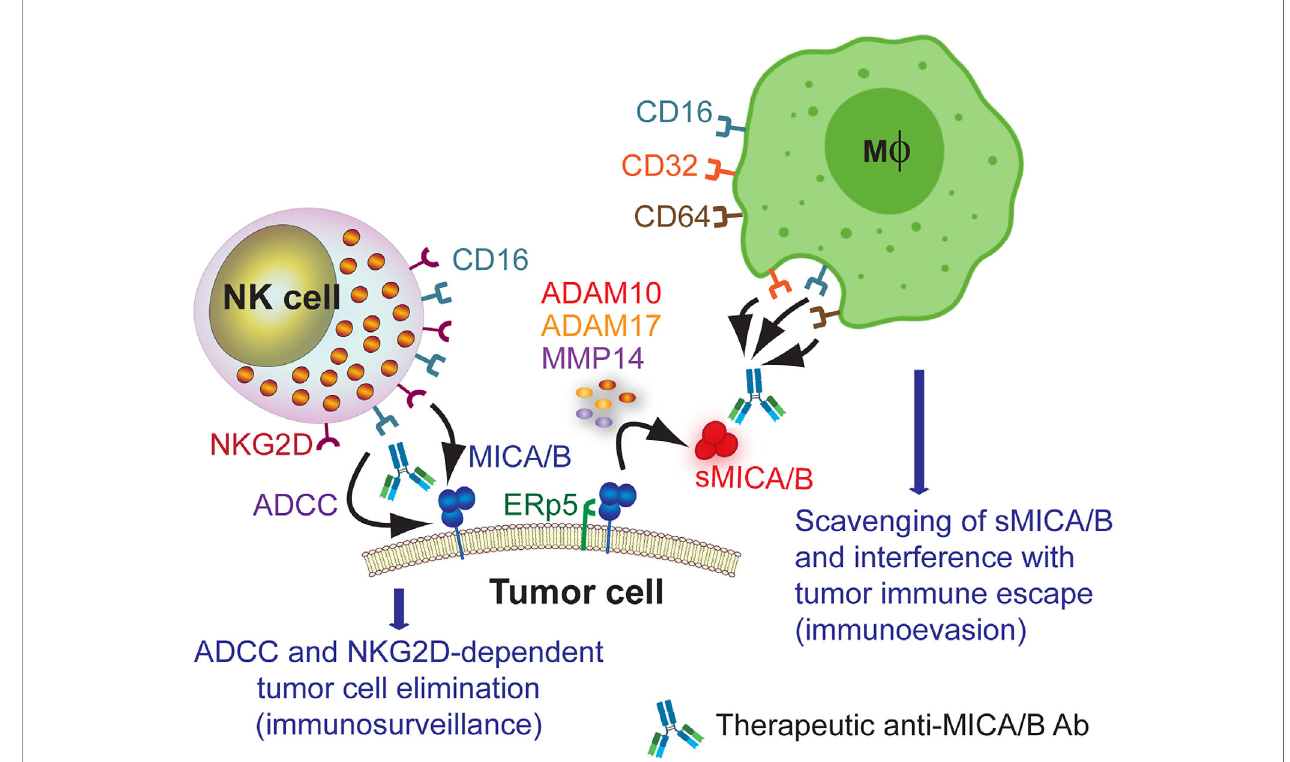
FIGURE 2 | Therapeutic opportunity for anti-MICA/B Ab. Administration of anti-MICA/B Ab may trigger CD16-dependent ADCC by NK cells when these Ab recognize cell surface-expressed MICA/B, contributing to tumor cell elimination. Ab that do not interfere with the binding of NKG2D to MICA/B also would trigger NKG2D-dependent NK cell-mediated cytotoxicity, further contributing to tumor cell elimination. Moreover, recognition of sMICA/B by these therapeutic anti-MICA/B Ab would lead to the formation of immune complexes that would be removed by macrophages upon recognition through CD16, CD32 and CD64. This scavenging of sMICA/B will consequently interfere with tumor immune escape